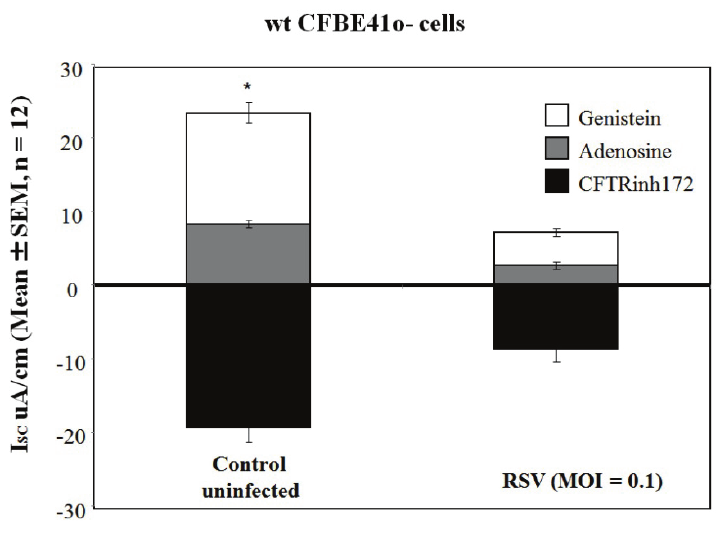
Figure 3. CFTR current measurements in control uninfected and RSV infected wt CFBE41o- cells. To measure CFTR dependent short circuit (I cultured on 6 mm diameter permeable inserts and mounted into modified Ussing chambers. Cell monolayers were stimulated with adenosine (10 μ M) and genistein (50 μ M) to